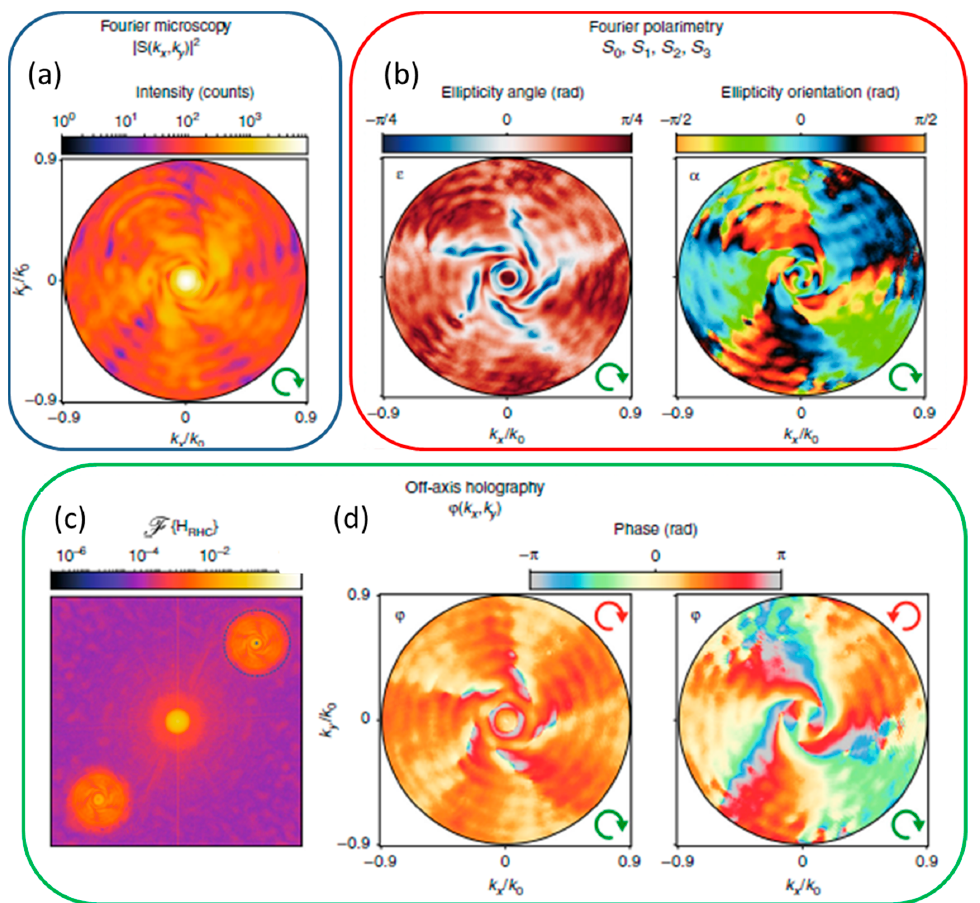
Figure 7. Demonstration of combined Fourier microscopy, polarimetry, and digital holography. R-state circular polarized input and an m = − 5 spiral nanostructure were used. ( a ) Fourier map of intensity; ( b ) reconstructed polarization ellipse parameters; ( c ) digital Fourier transform of an interferogram obtained with R-state circular polarized detection; ( d ) reconstructed phase maps for R-state and L-state circular polarized detection. The green and red arrows specify the input and output polarization, respectively (reprinted from Röhrich et al [53]).